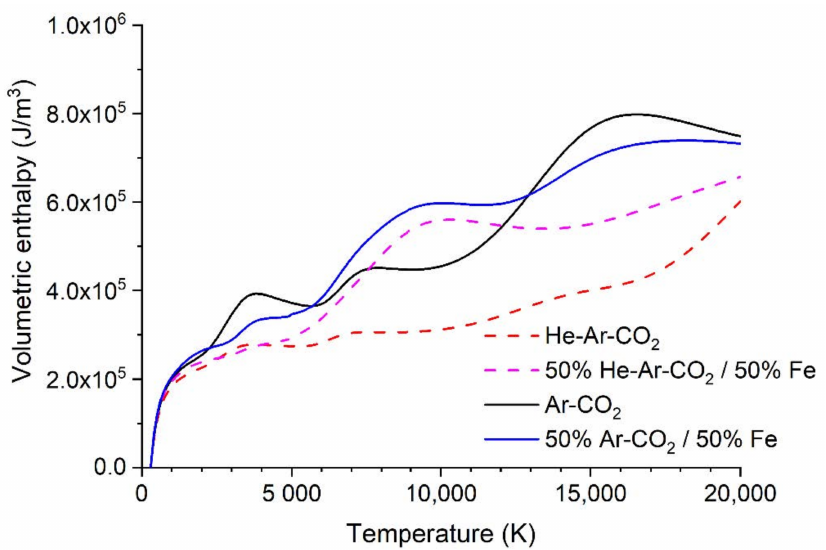
Figure 15. Volumetric enthalpy for the ternary and binary blends and for 50 mol% mixtures of each blend with metal vapor, as a function of